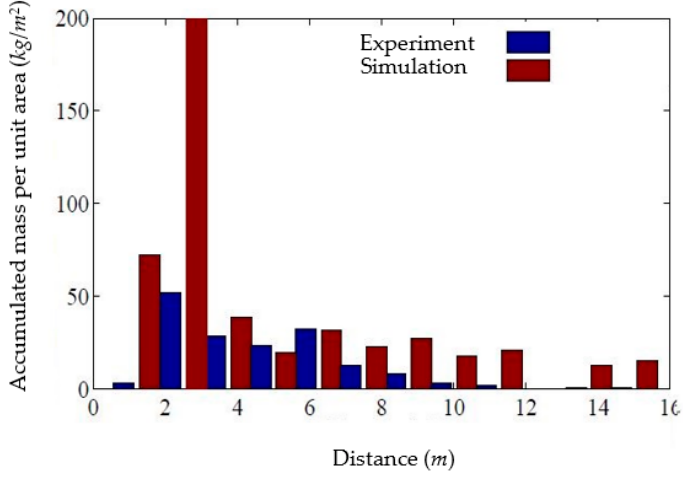
Figure 16. Accumulated mass relative to distance from the nozzle in a large-scale hall experiment [79].